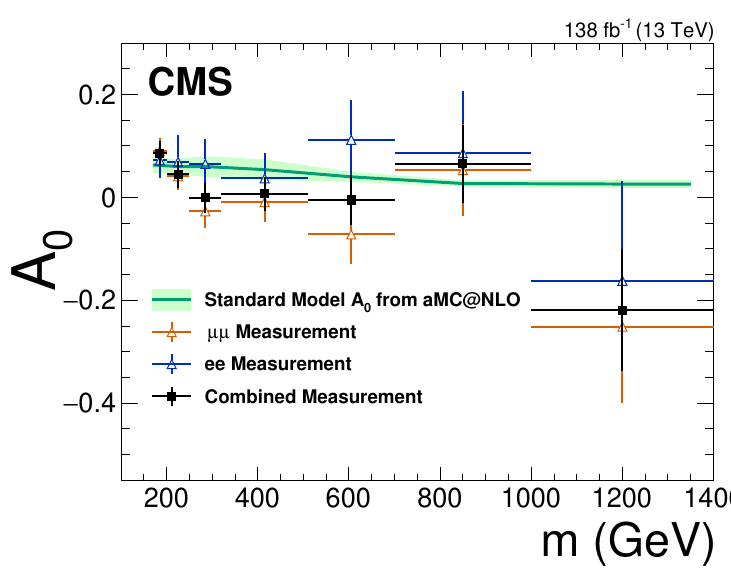
Figure 4 . Measurement of the DY forward-backward asymmetry as a function the dilepton mass compared with the MC predictions. The green line is the predicted value for A a MC@NLO simulation and the shaded green region its uncertainty. The red, blue, and black points and error bars represent the dimuon, dielectron, and combined measurements, respectively. Error bars on the measurements include both statistical and systematic